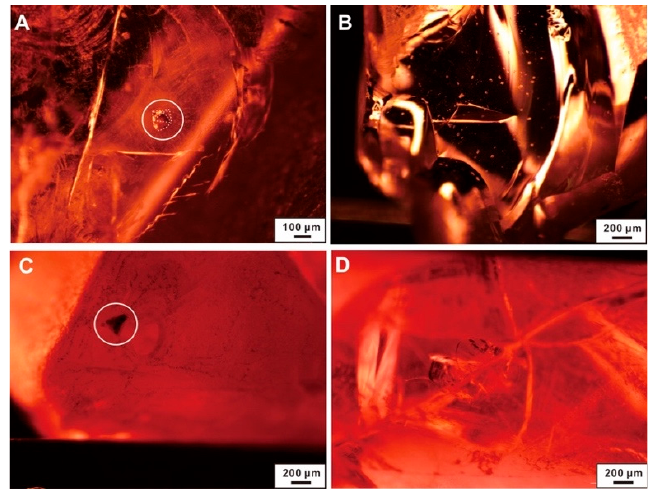
Figure 5. Internal features of Mogok pink and red spinel samples. ( A ) The octahedral crystal in the pink sample (B-3); ( B ) fine microgranular inclusions in the pink sample (B-8); ( C ) remnants of black octahedral inclusions in the red sample (B-11); ( D ) disk-like fissures in the red sample (B-13).